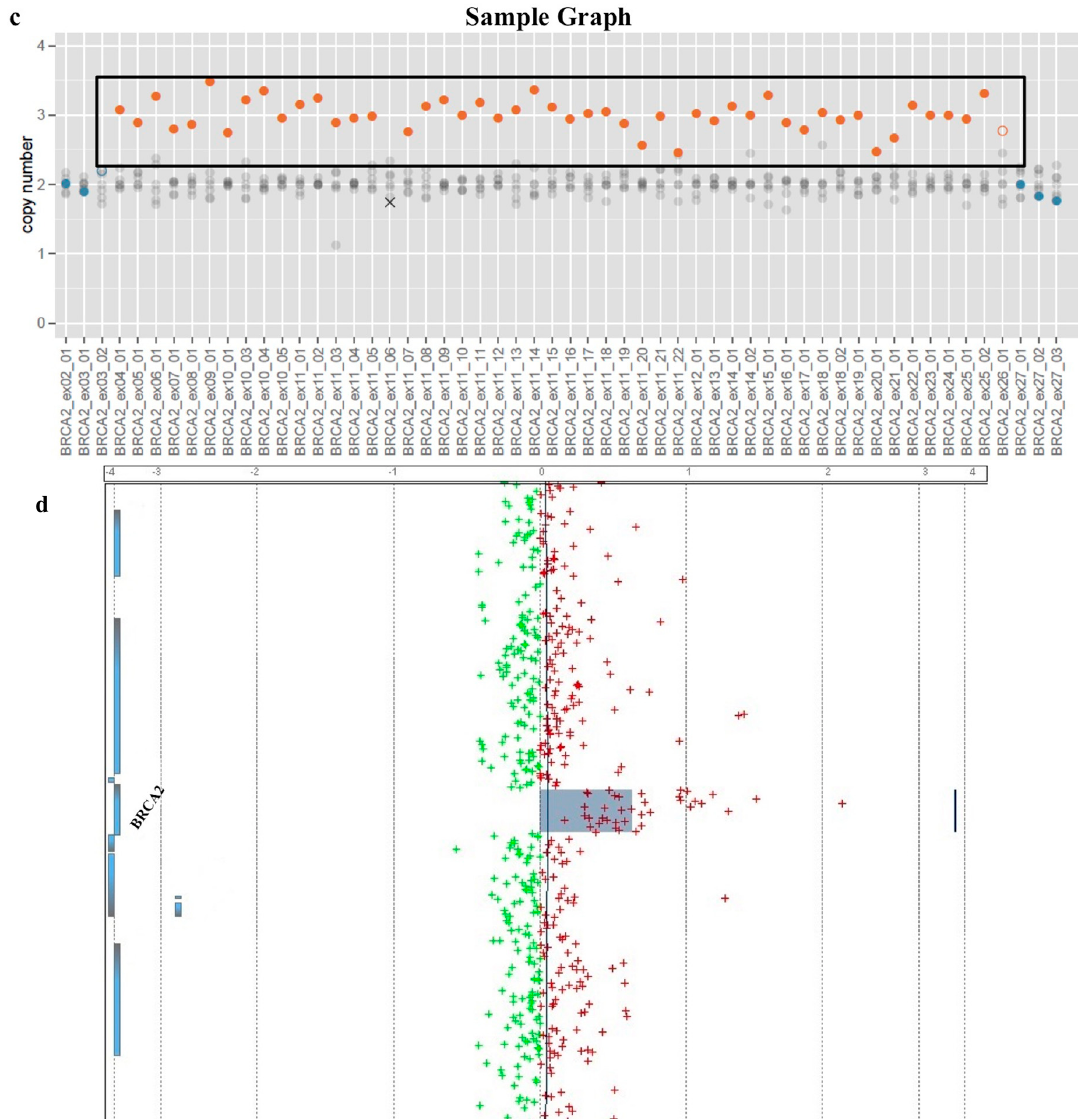
Figure 2. Large BRCA2 gene duplication. ( a ) Gene view of the global copy number variant (CNV) analysis of the BRCA1 and BRCA2 genes. The noise is low for both genes. BRCA1 contains no CNVs in any of the target amplicons, while BRCA2 presents a large duplication, from exon 4 to exon 26. ( b ) The CNV analysis of the BRCA2 gene. b1 BRCA2 with all the exons; b2 CNV target regions for all the 5 plexes of the MASTR BRCA DX (Multiplicom); b3 CNV confidence plot showing a high confidence for almost all target amplicons. ( c ) Sample graph for each amplicon in BRCA2 showing the large duplication. There is an undetermined region for the amplicon 11_06 probably due to a region difficult to analyze. ( d ) Array-based comparative genomic hybridization (a-CGH) profile of chromosome 13. This analysis shows heterozygous amplification in 13q13.1 of about 72 kb involving the BRCA2 gene. Green and red dots represent the log2 fluorescence ratios of individual oligonucleotide probes on the microarrays; red dots represent probes with positive log2 fluorescence ratios, whereas green dots represent probes with negative log2 fluorescence ratios.